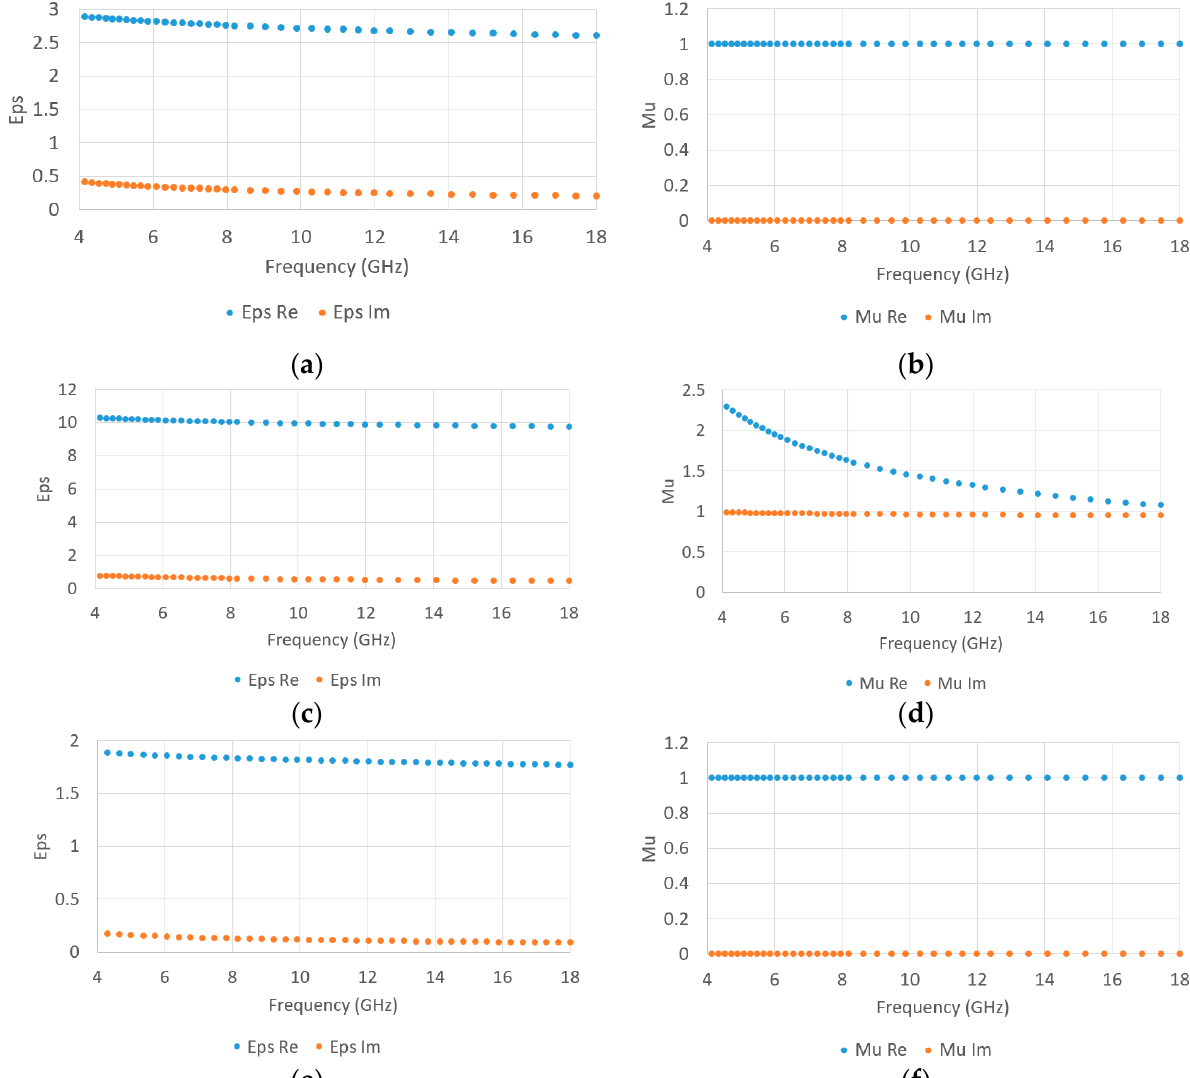
Figure 9. Characterization of the EM properties, with Eps Re = real permittivity, Eps Im = imaginary permittivity, Mu Re = real permeability, Mu Im = imaginary permeability: ( a ) the permittivity of the non-loaded filament, ( b ) the permeability of the non-loaded filament, ( c ) the permittivity of the magnetic loaded filament, ( d ) the permeability of the magnetic loaded filament, ( e ) the permittivity of the printed sample with a “Grid” pattern, ( f ) the permeability of the printed sample with a “Grid” pattern .